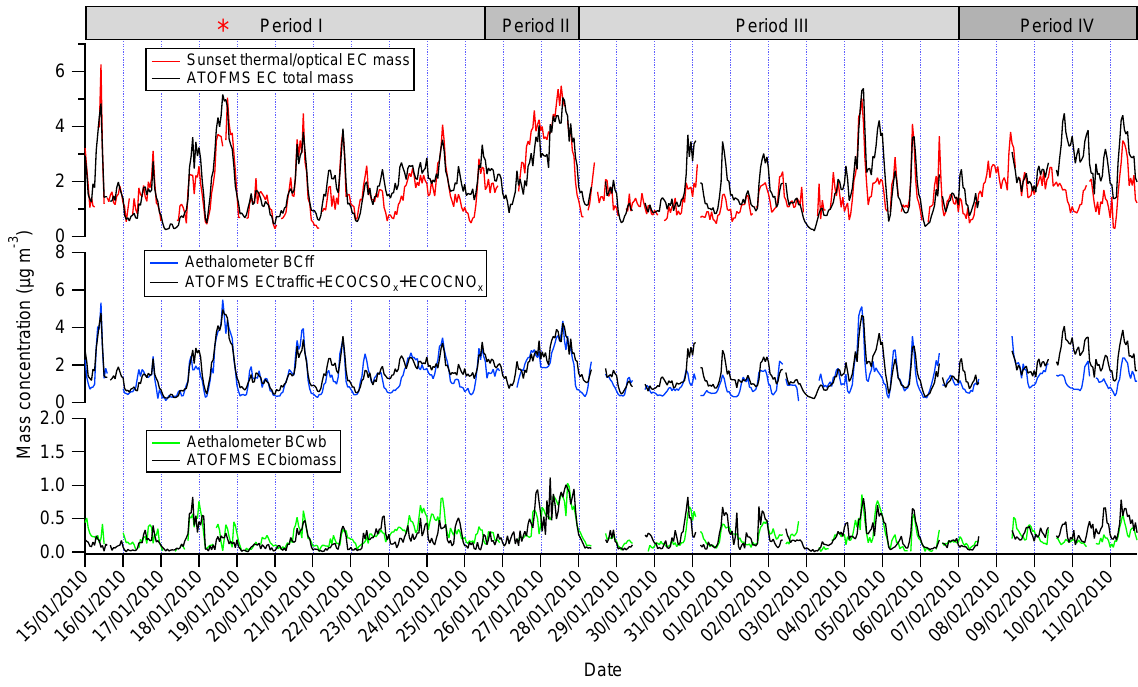
Fig. 7. Top: comparison of total scaled hourly ATOFMS EC particle mass concentration and hourly average Sunset thermal/optical EC mass concentration. Middle: scaled ATOFMS mass concentration for the sum of ECtraffic, ECOCSO x and ECOCNO x compared with hourly average modelled aethalometer BC ff mass concentration. Bottom: scaled ATOFMS mass concentration for ECbiomass compared with hourly average modelled aethalometer BC bb mass